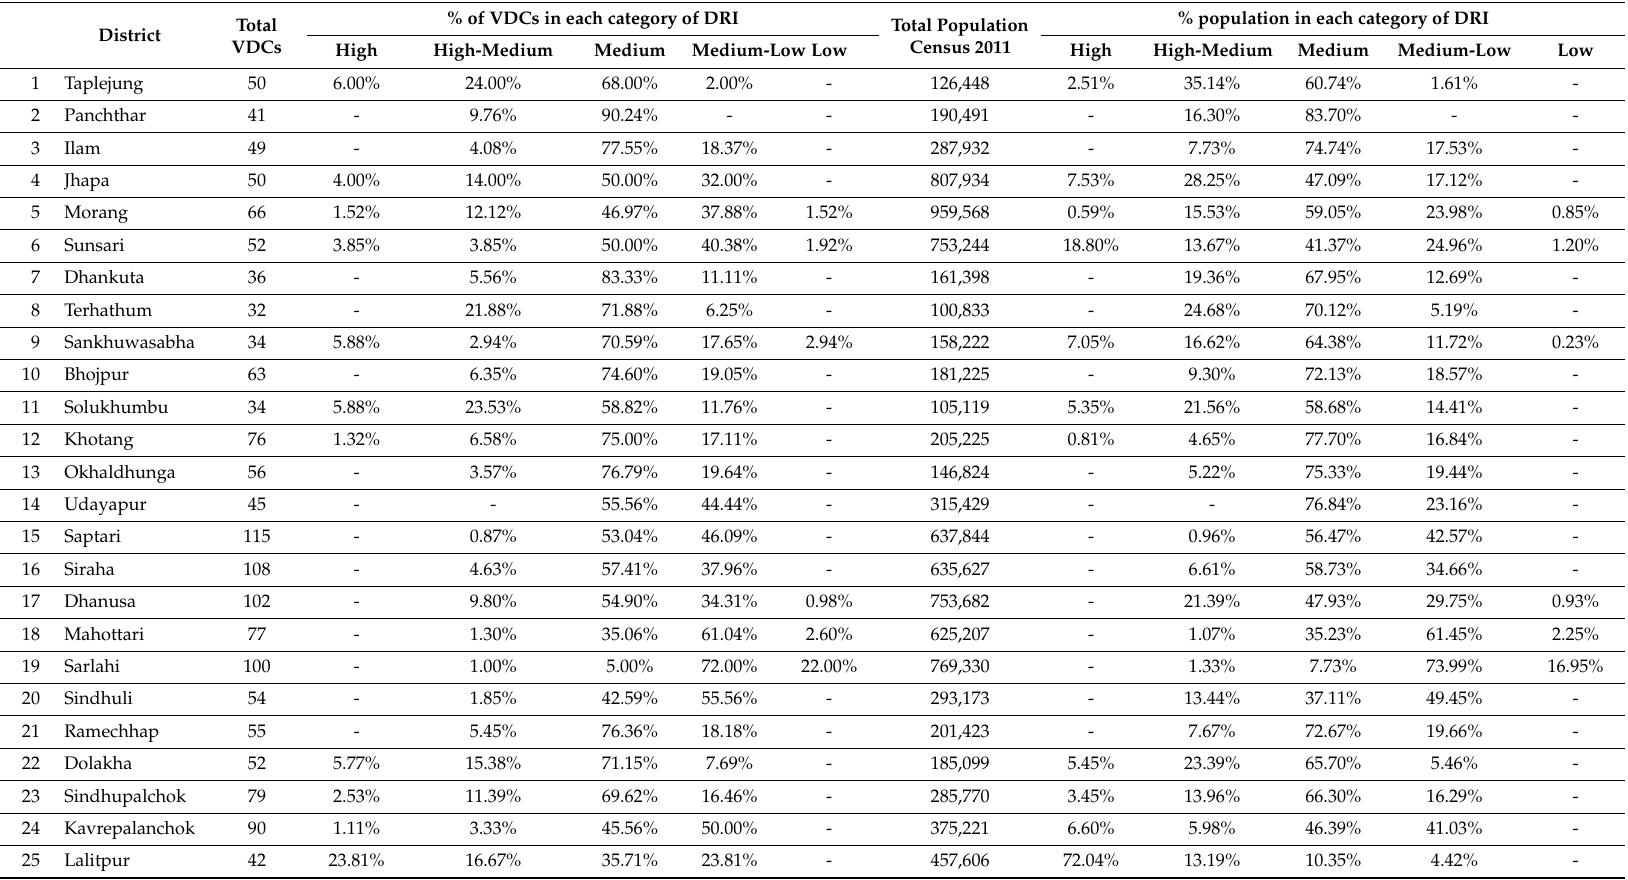
Table 6. Summary of VDCs and population in each CDRI class by the